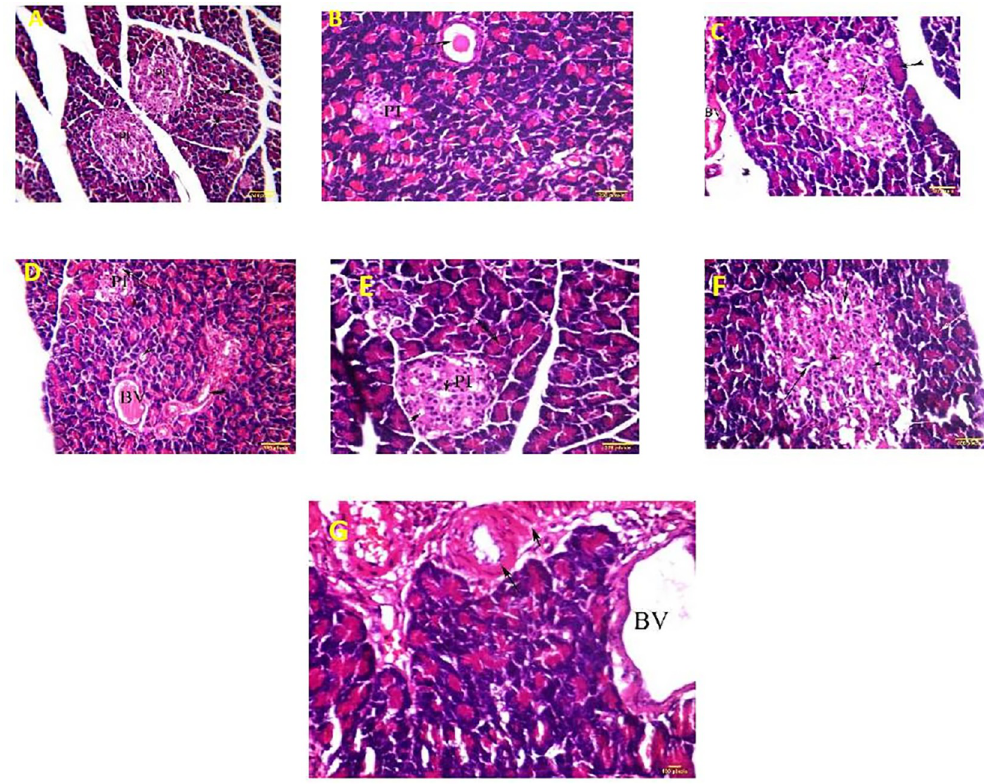
Fig 1. Photomicrographs of rat pancreases isolated from different animal groups. Photomicrographs of cross section of the pancreatic tissue of A : normal healthy animals showing normal pancreatic islets (PI) and pancreatic acini (arrow), B : diabetic group showing pancreatic duct inspissiated (arrow), pancreatic islet (pi) with sever reduction in size and hypocellularity. C : animals treated with REE 250 mg/kg showing: pancreatic islet (short arrow), inspissated pancreatic duct (long arrow) and blood vessel (double arrow) and pancreatic acini (arrow head). D : animals treated with REE 500 mg kg -1 bwt showing pancreatic islet moderate in size and dilated congested blood vessel (arrow). E: animals treated with 250 mg kg -1 bwt AEE showing pancreatic blood vessels with thickened walls (arrow) and perivascular fibrotic reaction (short arrow). F : animals treated with AEE (500 mg kg -1 bwt) showing islets with normal size and vaccuolation between cells (arrowhead), pancreatic duct (arrow). (H & E). G : Animals treated with metformin showing: pancreatic islets with vacuolation between cells (arrow), dilated congested blood vessel (BV), and intact pancreatic acini (double arrow).